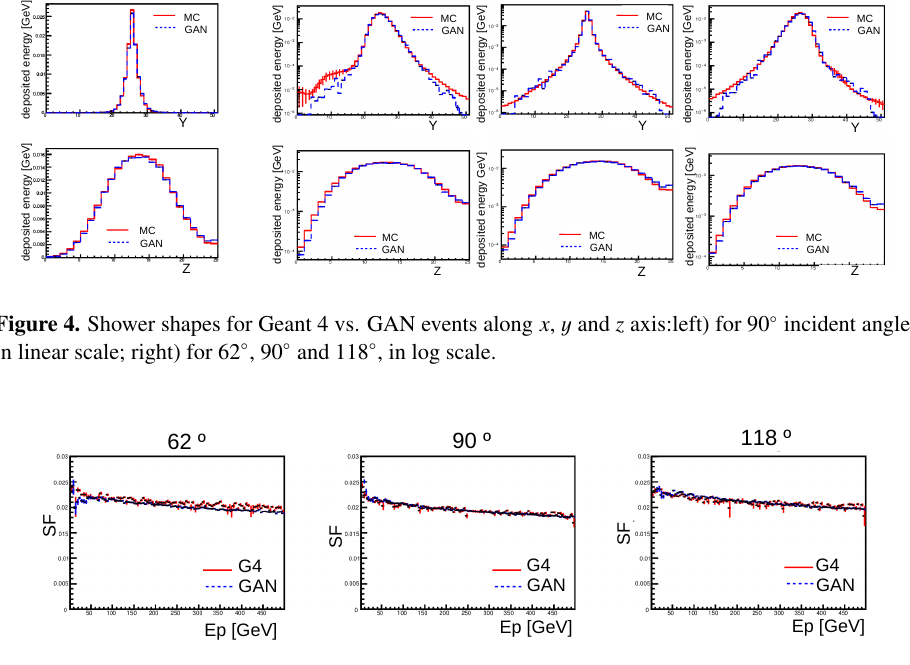
Figure 5. Sampling fraction for GAN and Geant4 events for three di ff erent angle